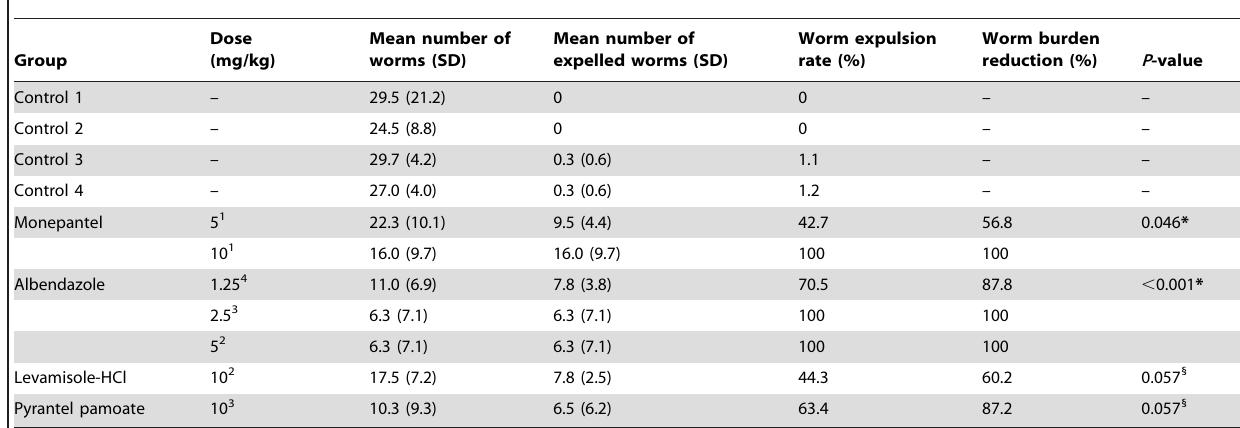
Table 3. Dose response relationships of monepantel, albendazole, levamisole, and pyrantel pamoate on A. ceylanicum in vivo .